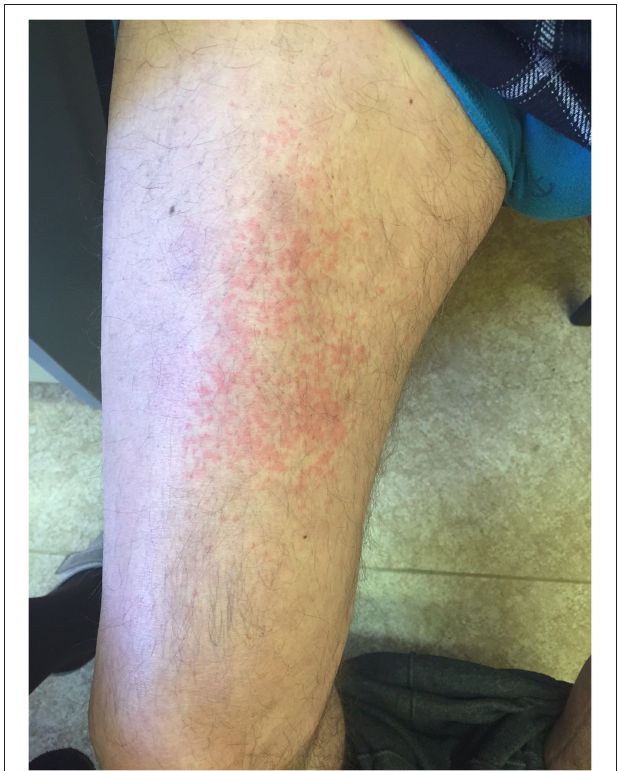
FIGURE 3 | Skin rash in patient